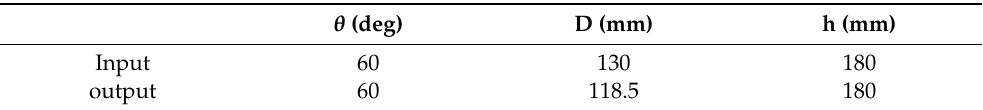
Figure 11. Schematic of undercut. Table 5. Parameters of undercuts.